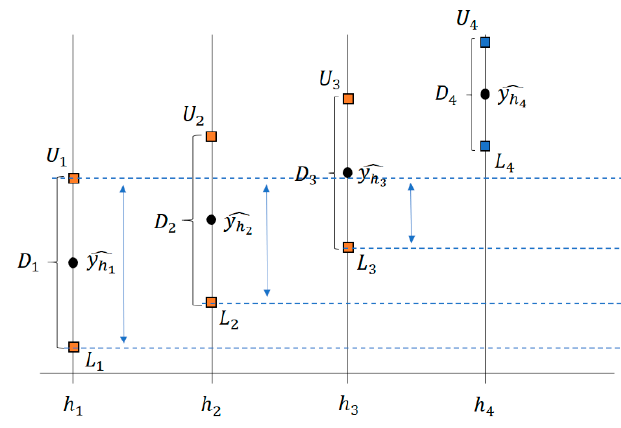
Figure 1. Illustration of the ICI rule tracking the intersection of the confidence intervals.